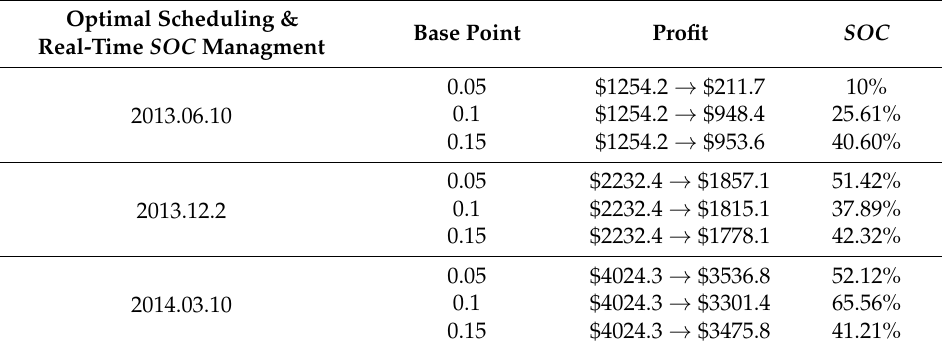
Table 3. Additional simulation case